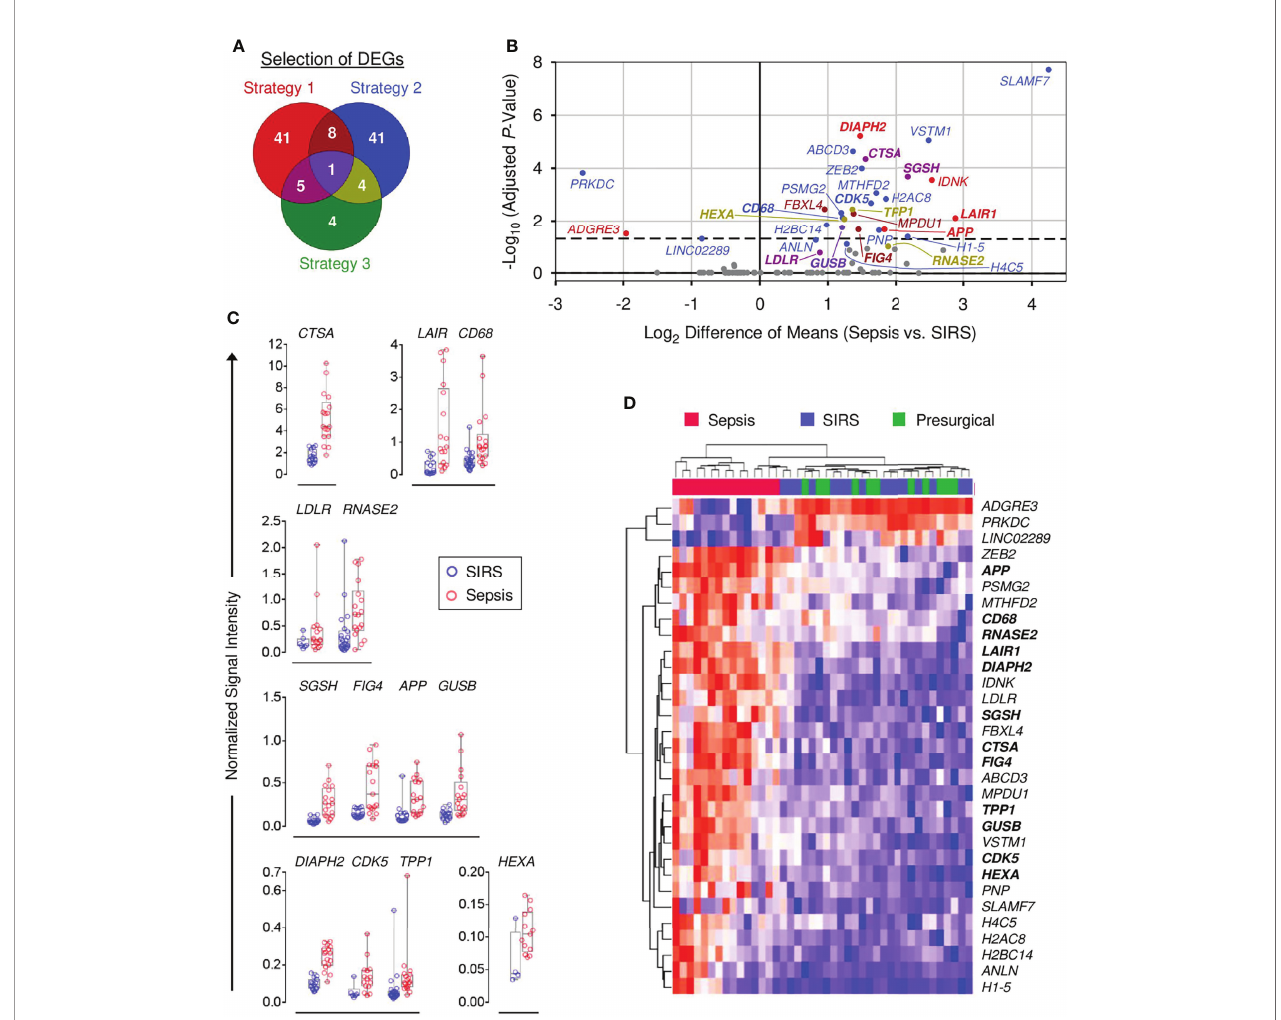
FIGURE 2 | Validation of differential gene expression in sepsis and SIRS CD15 + cells. (A) Venn diagram for strategies 1 – 3 to select differentially expressed genes (DEGs) for validation (see main text). (B) QuantiGene Plex (QGP) validation results [ n (sepsis/SIRS) = 18/22 or 17/15]. Statistical signi fi cance after Bonferroni adjustment for 93 DEGs with con fi rmed expression in both patient groups, out of 104 selected, is plotted vs. fold-change. Validated DEGs and their corresponding regions in the Venn diagram in (A) are identi fi ed by the same color code as in (A) . Nonvalidated DEGs are shown in gray. Names of the 13 endo-lysosomal genes are printed in bold. The dashed line indicates a globally adjusted p -value of 0.05. Some validated DEGs lie below this global threshold because validation was determined by the statistical test results within the separate shortlists of DEGs by strategies 1 – 3. (C) Normalized QGP signal intensity distributions for the 13 validated DEGs with endo-lysosomal associations. Group comparisons are arranged by similar intensity ranges. (D) Clustered heat map of validated DEGs in the discovery set microarray data (sepsis, n = 15; SIRS, n = 16; presurgical = 11). Blue indicates the minimum and red the maximum expression. The 13 endo-lysosomal genes are highlighted in bold